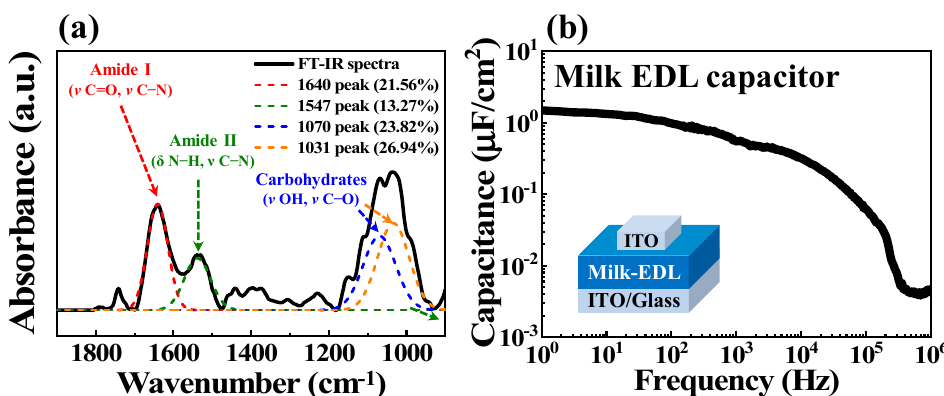
Figure 2. ( a ) FT-IR spectrum of the dried bovine milk-EDL membrane. ( b ) Frequency-dependent capacitance of ITO/milk-EDL/ITO-structured capacitors.